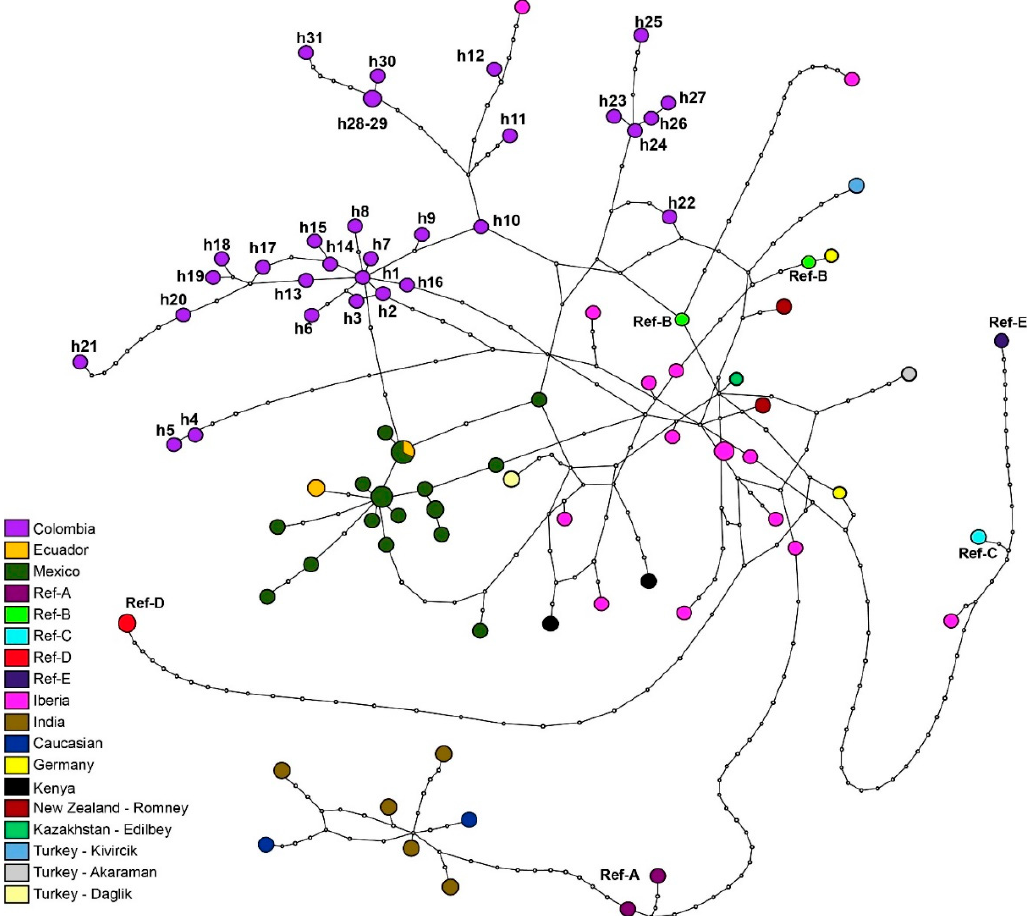
Figure 5. Pattern of 31 mtDNA haplotypes in Colombian Creole sheep and their genetic relationships with 62 reference haplotypes (Table S2). Each haplotype is represented by a circle with size proportional to the number of shared sequences; the small white circles indicate mutational changes and each country or breed are color-coded according to the legend. Reference lineages are listed as Ref, while the Colombian haplotypes are listed h1–h31.